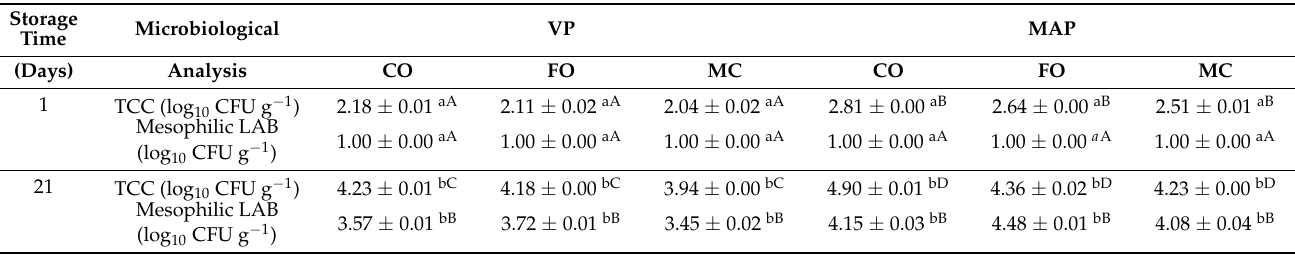
Table 2. Changes in the value of the total colony count (TCC) and the count of mesophilic lactic acid bacteria (LAB) in the poultry sausages depending on the type of packing and storage